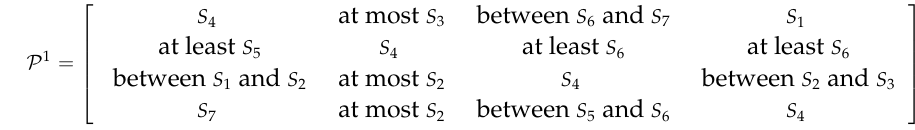
(cid:8) (cid:9) = { p 1 S 4 , at most S 3 , between S 6 and S 7 , S 1 } , p 1 , p 1 , p 1 11 12 13 14 (cid:17) (cid:16) (cid:17)(cid:17) (cid:16) (cid:16) Sum p 1 p 1 , φ , j = 1 j 1 j (cid:0) (cid:1) < (cid:0) (cid:1) < (cid:0) (cid:1) = (cid:0) (cid:1) (cid:0) (cid:1) = 3 < p 1 Sum p 1 Sum p 1 Sum p 1 p 1 and φ 13 14 12 11 12 2